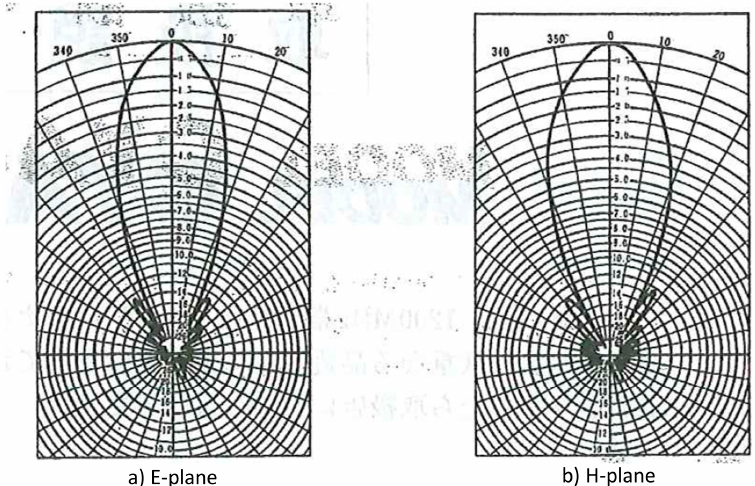
Figure 4. Antenna pattern for the Yagi antenna for the GB-radar system. ( a ) E-plane. ( b ) H-plane.